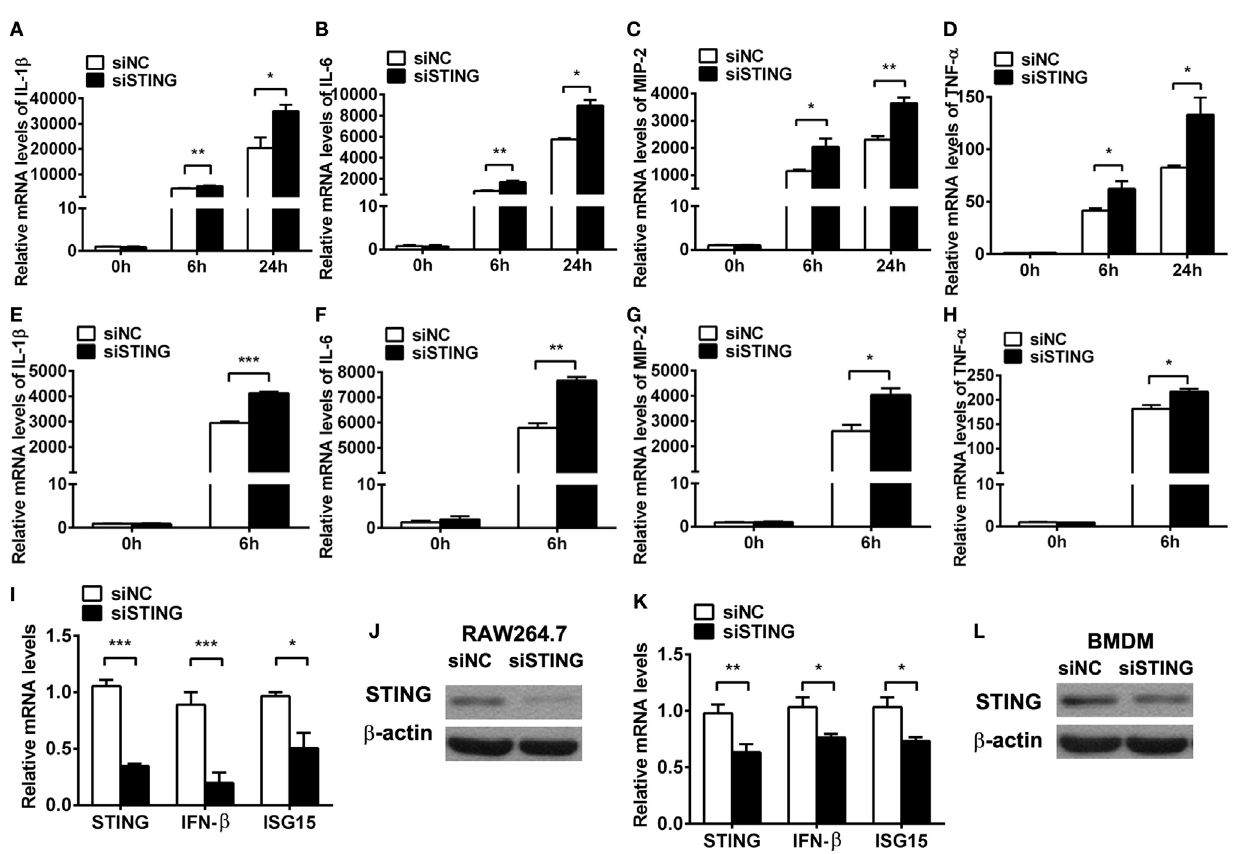
FigUre 5 | Silencing stimulator of interferon genes (STING) enhanced inflammatory cytokine expression. (a–D) mRNA levels of interleukin 1 beta (IL-1 β ) (a) , interleukin 6 (IL-6) (B) , macrophage inflammatory protein 2 (MIP-2) (c) , and tumor necrosis factor α (TNF- α ) (D) were measured by using real-time PCR at 6 and 24 h postinfection (p.i.) in murine macrophage-like RAW264.7 cells with siRNA for mouse STING (siSTING) versus siNC treatment. (e–h) mRNA levels of IL-1 β (e) , IL-6 (F) , MIP-2 (g) , and TNF- α (h) were measured by using real-time PCR at 6 h (p.i.) in bone marrow-derived macrophages with siSTING versus siNC treatment. (i,K) mRNA levels of STING, IFN- β , and interferon-stimulated gene 15 (ISG15) were measured by using real-time PCR in RAW264.7 cells (i) and bone marrow-derived macrophage (BMDM) (K) with siSTING versus siNC treatment. (J,l) Protein levels of STING were measured by using Western blot in RAW264.7 cells (J) and BMDM (l) with siSTING versus siNC treatment. Data are shown as mean ± SEM of three independent experiments. * P < 0.05; ** P < 0.01; and *** P <